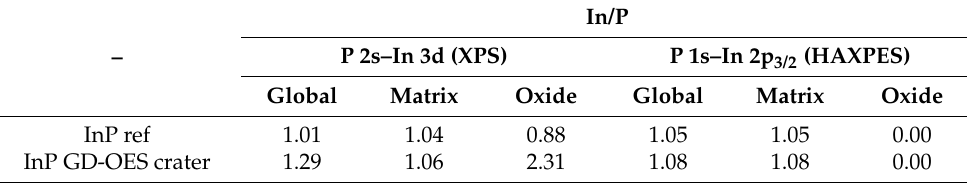
Table 2. In/P atomic ratios determined using XPS P 2s–In 3d and HAXPES P 1s–In 2p 3/2 set of pho- topeaks.